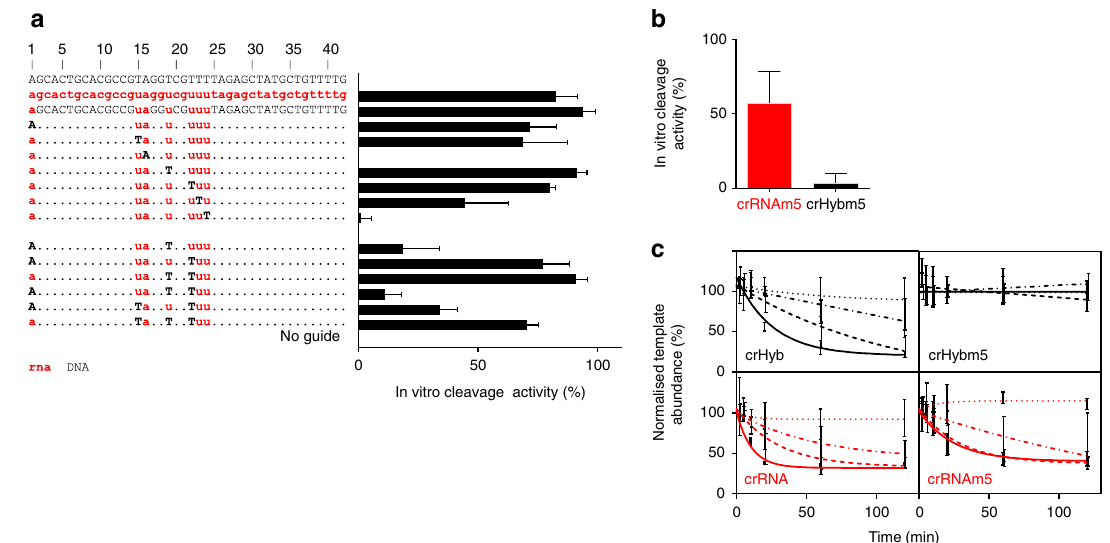
Fig. 2 Cas9:tracrRNA can function with a crXNA composed of 88% DNA and crHyb show enhanced speci fi city. a RNA nucleosides within the crHyb for GFP target 1 were sequentially converted to DNA and activity assessed by DNA fragmentation assay. Nucleotides coloured as in Fig. 1a. b A single base C > A mismatch was introduced into crRNA and crHyb molecules and activity assessed. All bars show mean + SD, n = 3 – 13. c Kinetics of template degradation driven by Cas9:tracrRNA complexed with crHyb (black) or crRNA (red), either with perfect complementary (left) or with a single base-pair mismatch (right). Graphs show normalised template abundance (%) over time, with Cas9 protein at 5 nM (solid line), 2.5 nM (long dash line), 1.25 nM (dot dash line) or 0.625 nM (dotted line). Error bars show SD of 3 – 4 independent